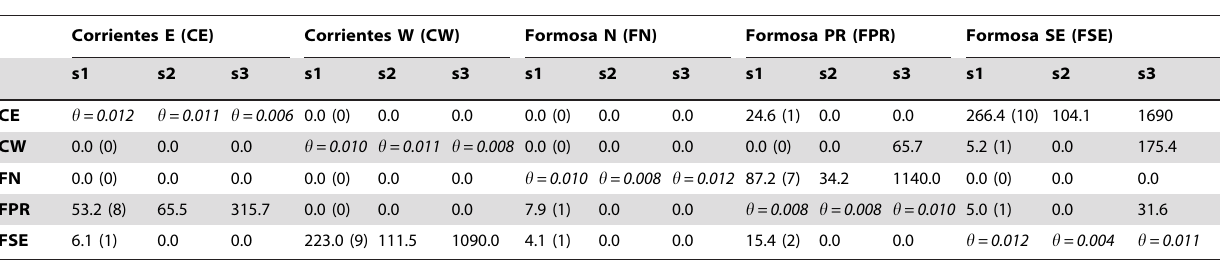
Table 3. Results of migration